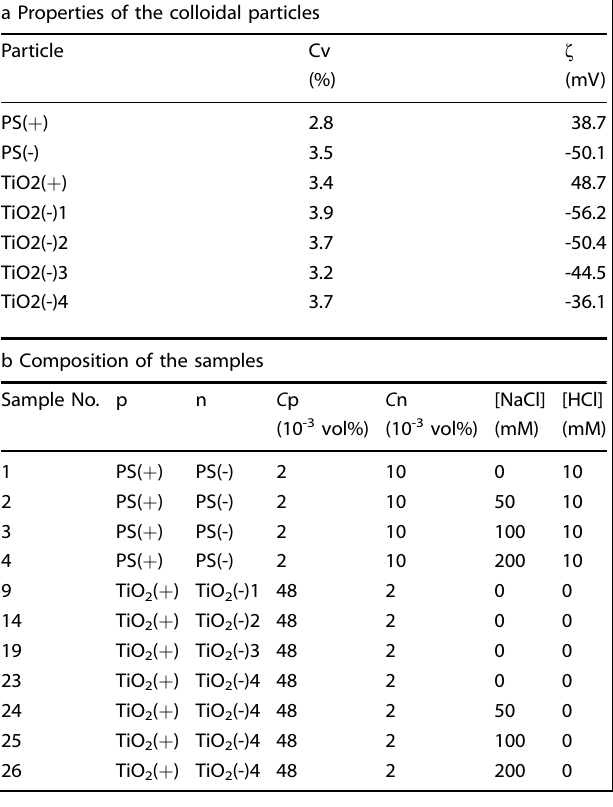
Table 1. Samples used in the space